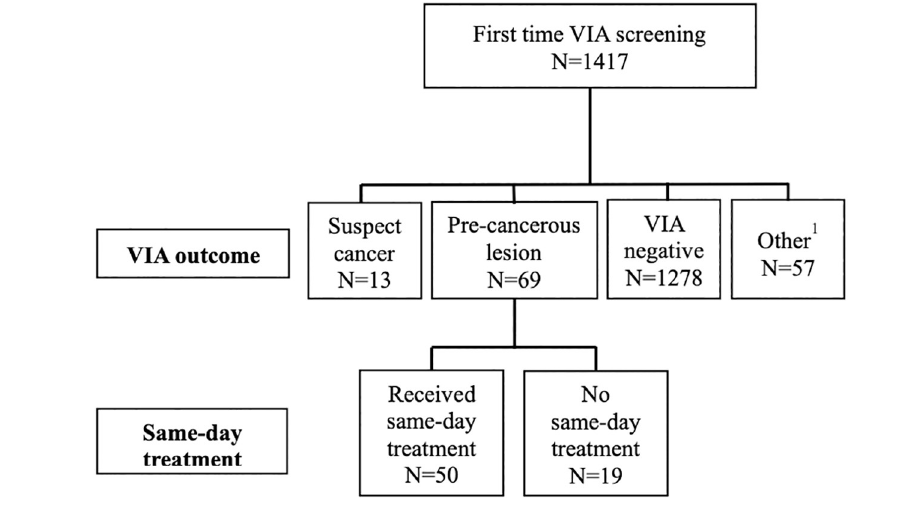
Fig 1. VIA screening visits, June 2017-October 2019: Results and same-day treatment flow chart.